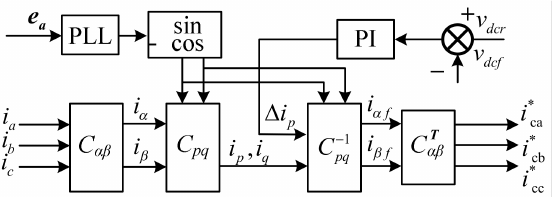
Figure 5. Block diagram for the detection of the fundamental reactive power component.